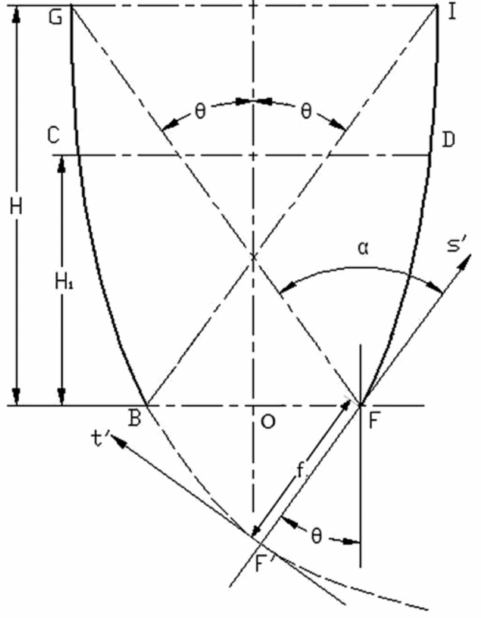
Figure 2. Geometric schematic of CPC. Reprint with permission [25]. Copyright 2017, Elsevier.